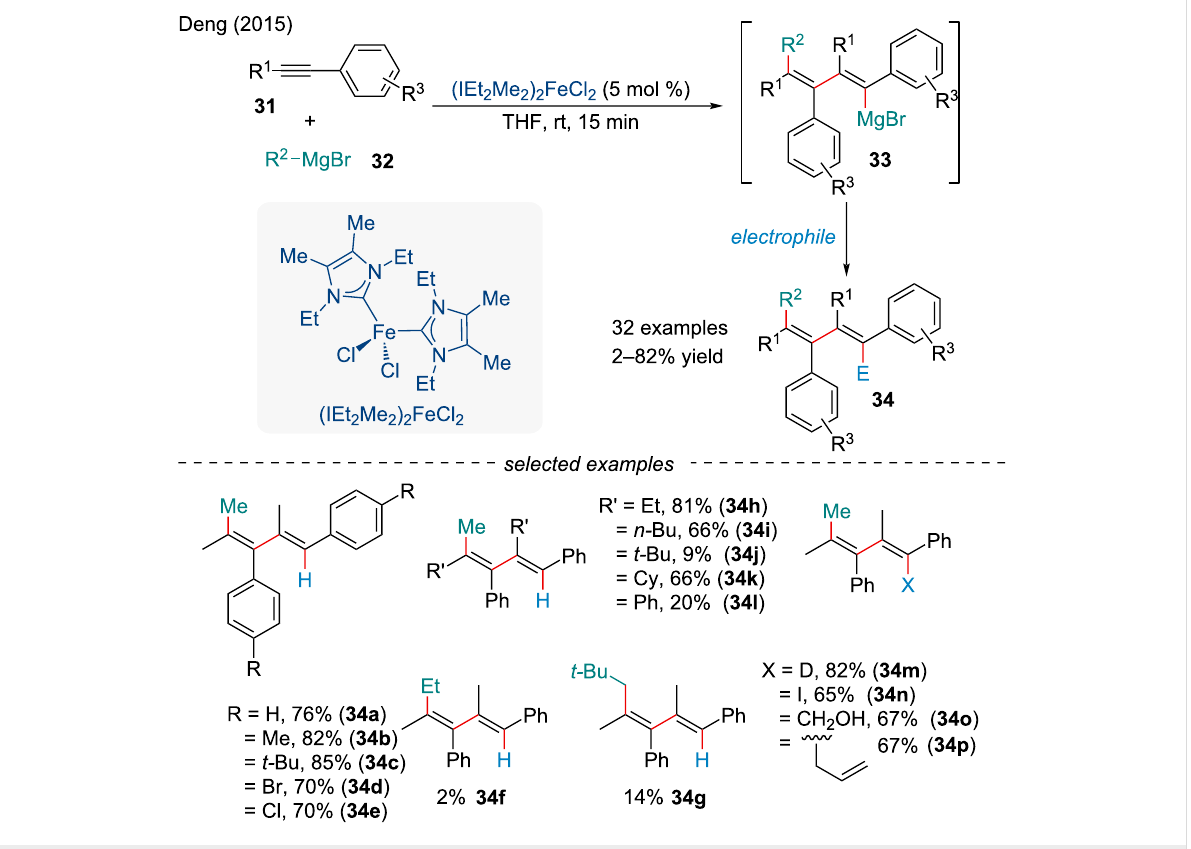
Scheme 6: Double carbomagnesiation of internal alkynes 31 with alkyl Grignard reagents 32